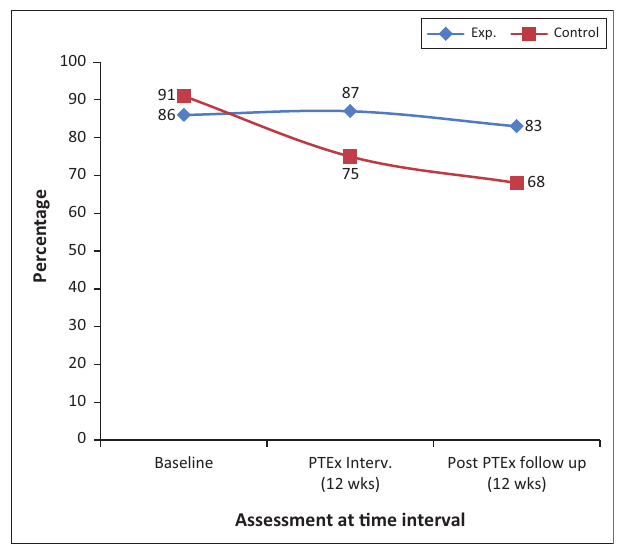
FIGURE 4: The percentages of participants with neuropathic pain at baseline, 12 and 24 weeks, in the intervention and control groups.